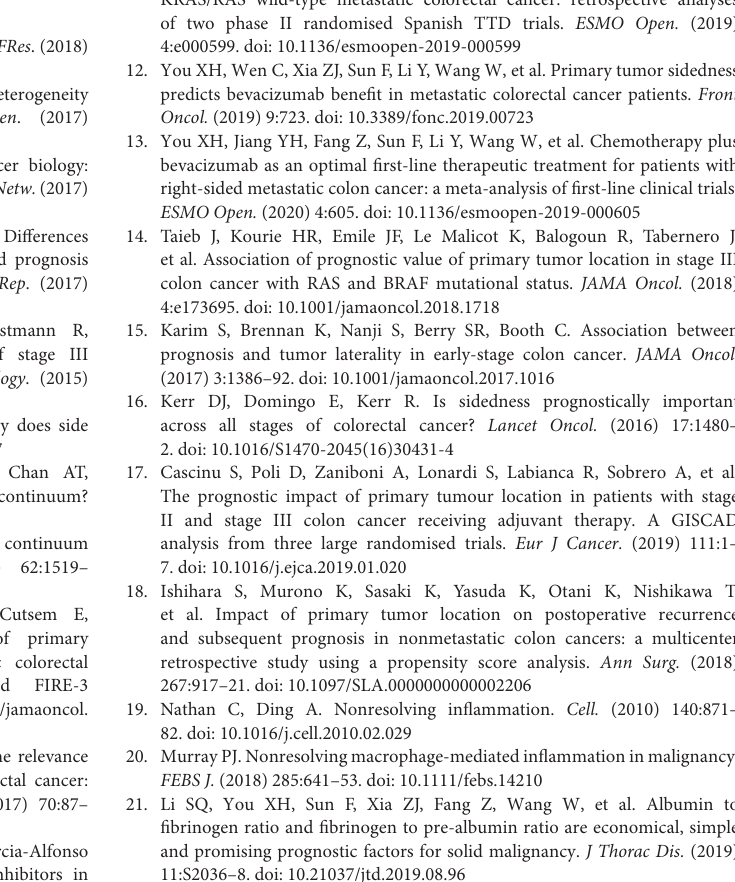
Supplementary Figure 1 | Survival comparison in overall or stage III population. (A) Kaplan–Meier curves for Recurrence-free survival (RFS) in stage I-III patients with rectal and left-sided (excluded rectum) cancer; (B) Kaplan–Meier curves for overall survival (OS) in stage I-III patients with rectal and left-sided (excluded rectum) cancer; (C) Kaplan–Meier curves for RFS in stage III patients with rectal and left-sided (excluded rectum) cancer; (D) Kaplan–Meier curves for OS in stage III patients with rectal and left-sided (excluded rectum) cancer; (E) Kaplan–Meier curves for RFS in FPR-high or FPR-low patients with right-sided or left-sided stage III cancer; (F) Kaplan–Meier curves for OS in FPR-high or FPR-low patients with right-sided or left-sided stage III cancer; (G) Kaplan–Meier curves for RFS in non-chemotherapy treated patients, low FPR chemotherapy-treated cases and first-line 5-FU, XELOX, FOLFOX treated high FPR subgroups; (H) Kaplan–Meier curves for RFS in FPR-high or FPR-low patients receiving radiotherapy. FPR, Fib to pre-Alb ratio; CT, chemotherapy; 5-FU, 5-fluorouracil; XELOX,